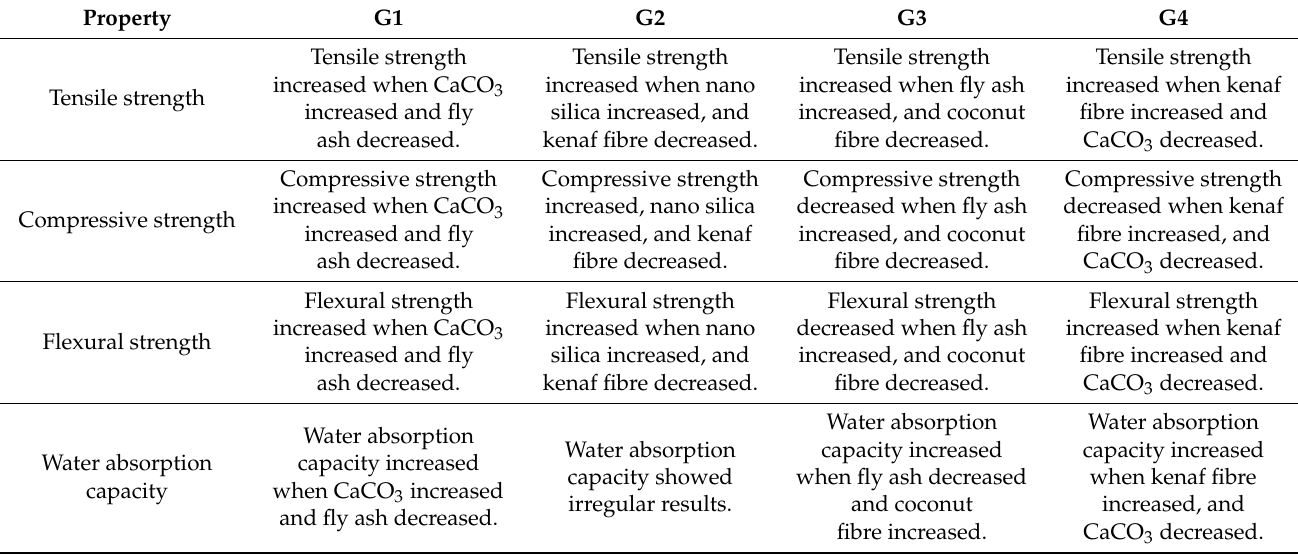
Figure 1. Tensile strength of the hybrid GFRP composites. Table 2. Comparative matrix of the tested